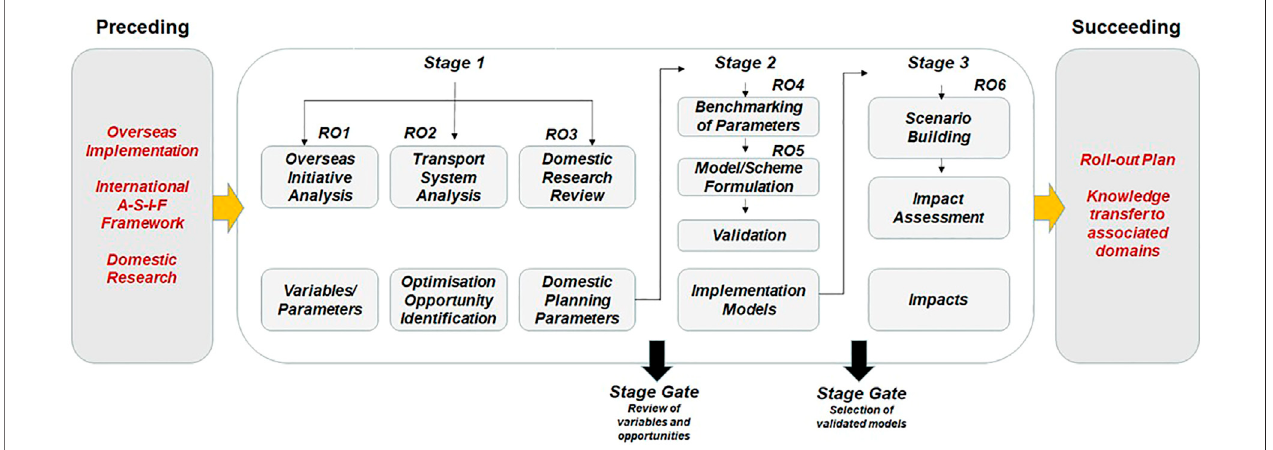
FIGURE 10 | The Research Plan (Authors ’